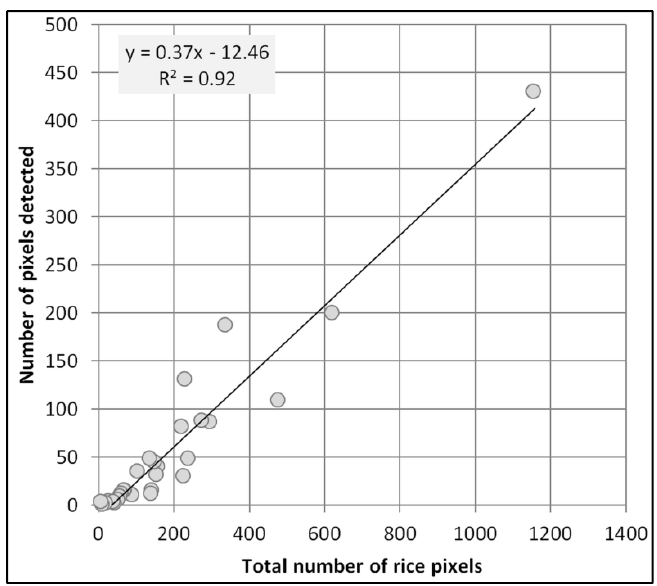
Figure 6. The relationship between the number of MODIS pixels where rice phenological dates were retrieved and the corresponding SAR derived rice area resampled at MODIS resolution in each